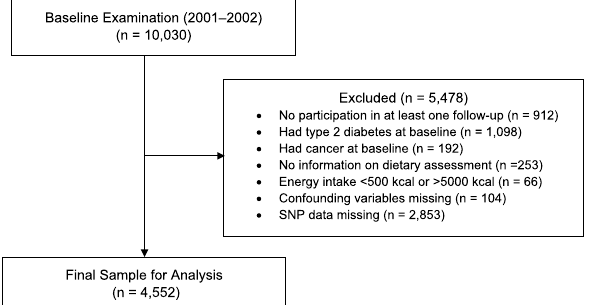
Figure 2. Flowchart of the study